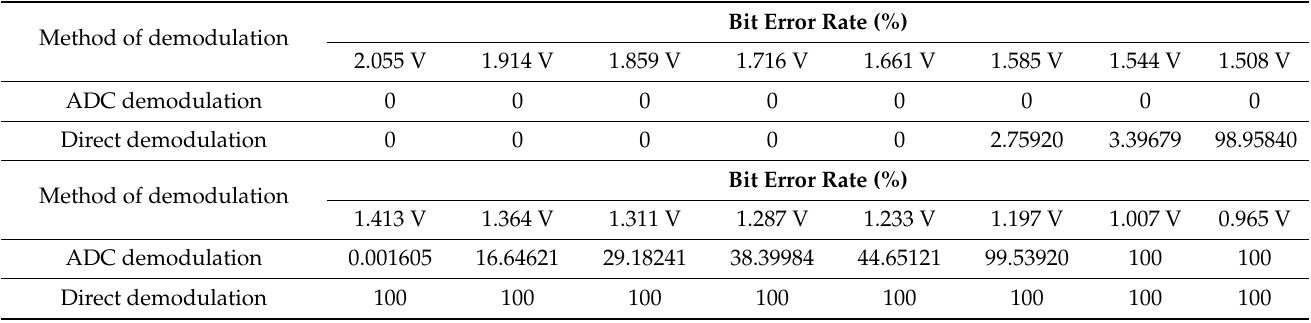
Figure 14. Picture transmission test chart for changing reception angle. Table 2. Bit error rate corresponding to different pulse amplitudes at the